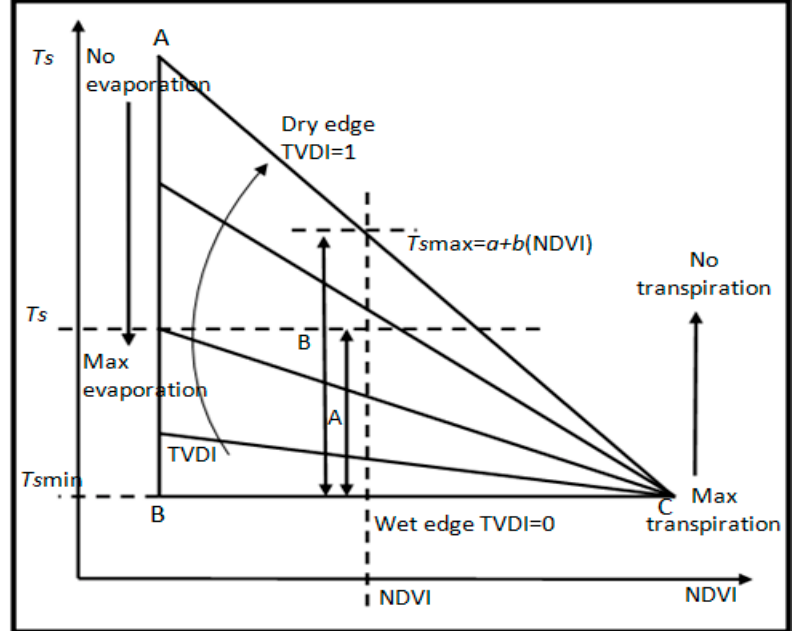
Figure 2. Simplified normalized difference vegetation index–land surface temperature (NDVI–LST) space [21]. A represents maximum dryness, B represents maximum wetness, and C represents maximum transpiration. The TDVI for a pixel (NDVI/LST) can be estimated as the position between lines A and B.